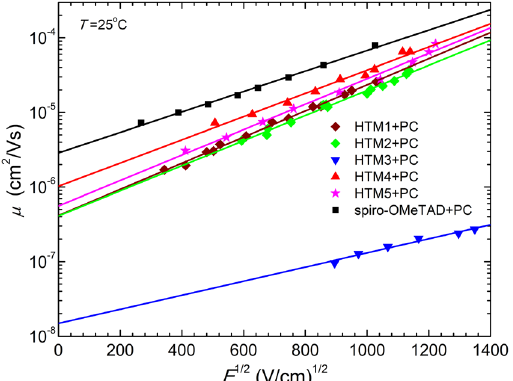
Figure 5. Electric-field dependencies of the hole drift mobilities in charge-transport layers of HTM1–5 dispersed in polycarbonate polymeric matrix.